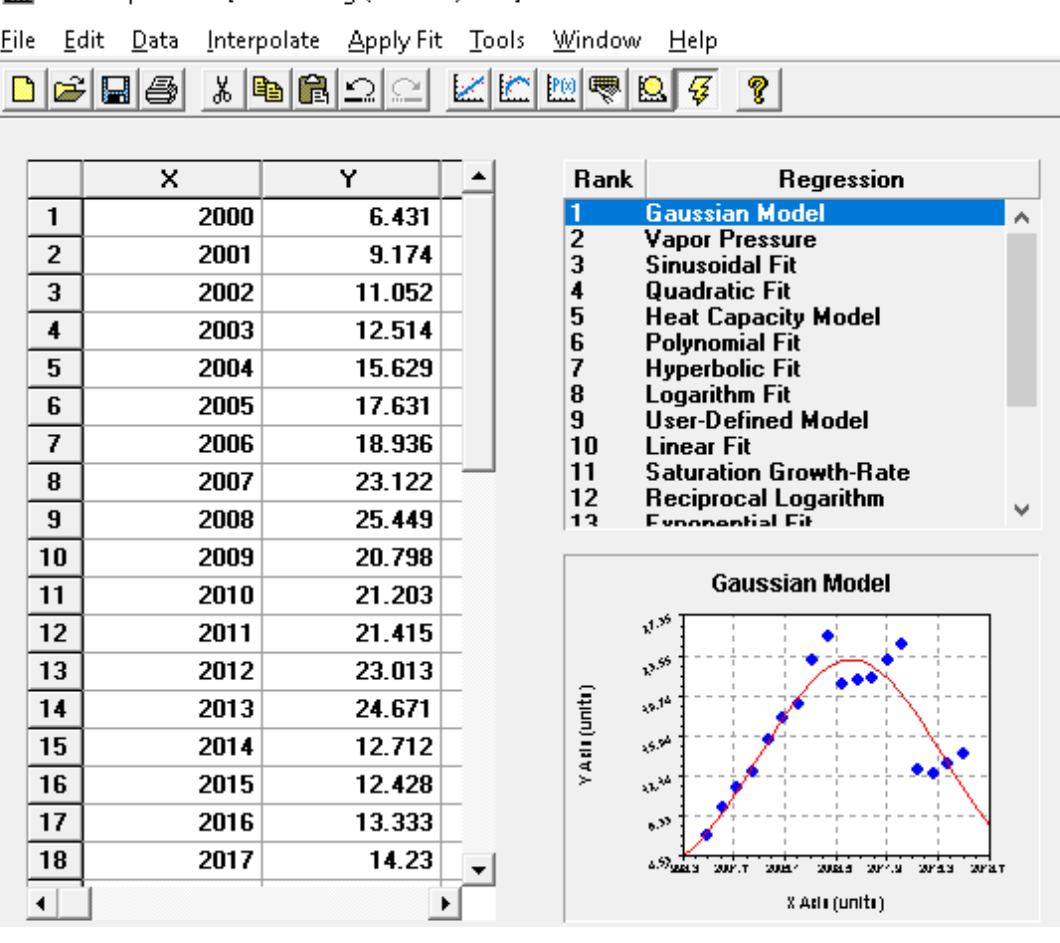
Figure 2. Building of forecast model by